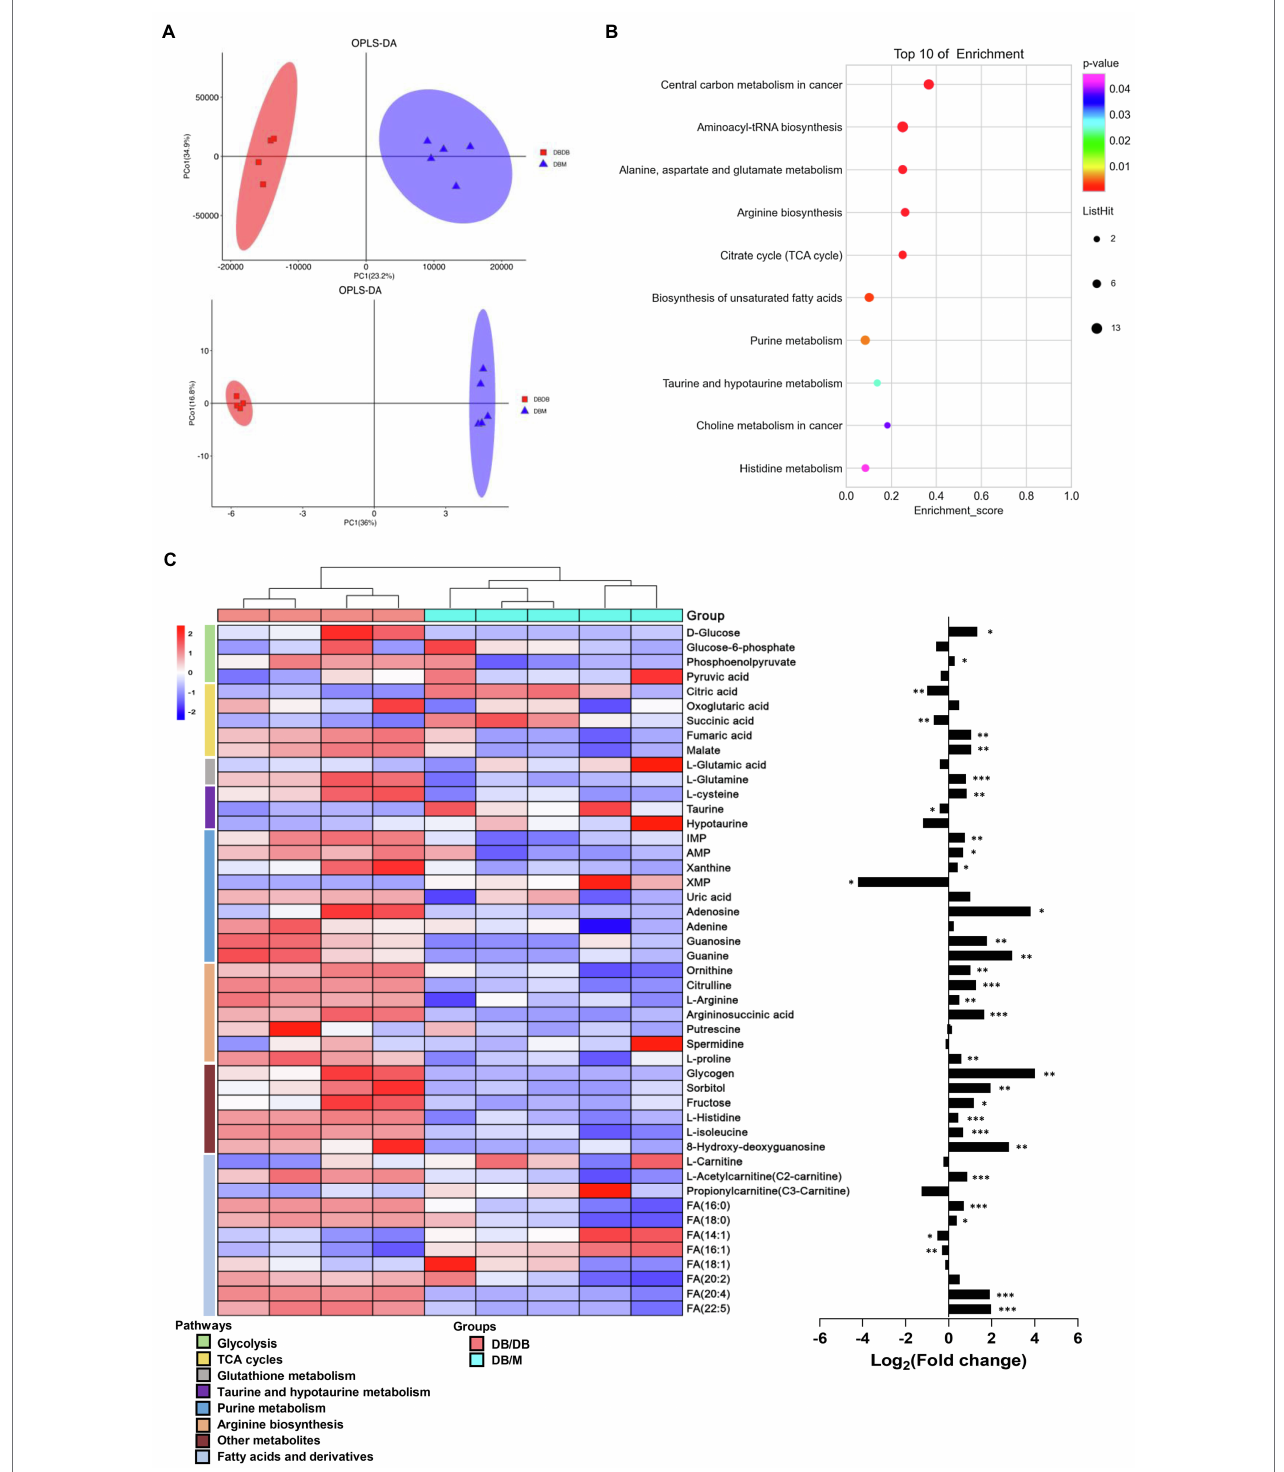
FIGURE 6 | Integrated metabolomics analysis between kidneys of db/m ( n = 5) and db/db ( n = 4) mice. (A) OPLS–DA plots of the metabolites detected in kidneys of db/m and db/db mice in GC–MS (upper) and UPLC–MS (down). (B) The bubble plot showing the integrated of GC–MS and UPLC–MS enriched in KEGG pathways of metabolites with VIP score ≥ 1.0 between kidneys of the two groups. (C) The heat map (left) illustrating the levels of metabolites in kidneys of db/m and db/db mice, each row represents one metabolite, each column represents one sample. Bar graphs (right) showing fold changes converted to logarithms in db/db mice compared to db/m mice. * p < 0.05, ** p < 0.01, and *** p < 0.001 difference between db/m and db/db mice ( t